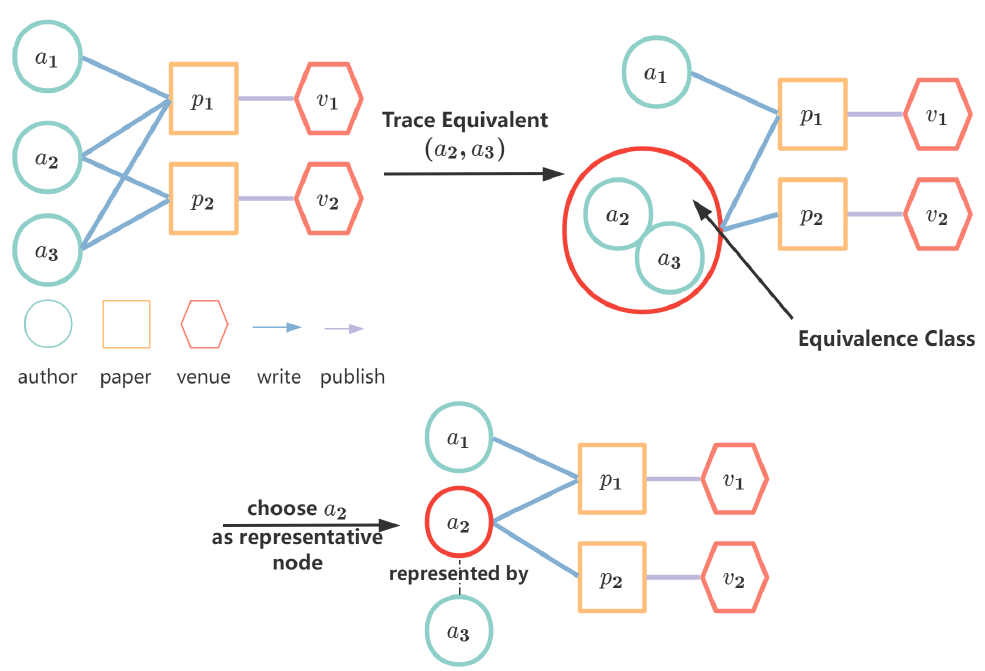
Figure 3. Procedure of generating equivalence class and choosing one representative node of equiva- lence class on behalf of the whole